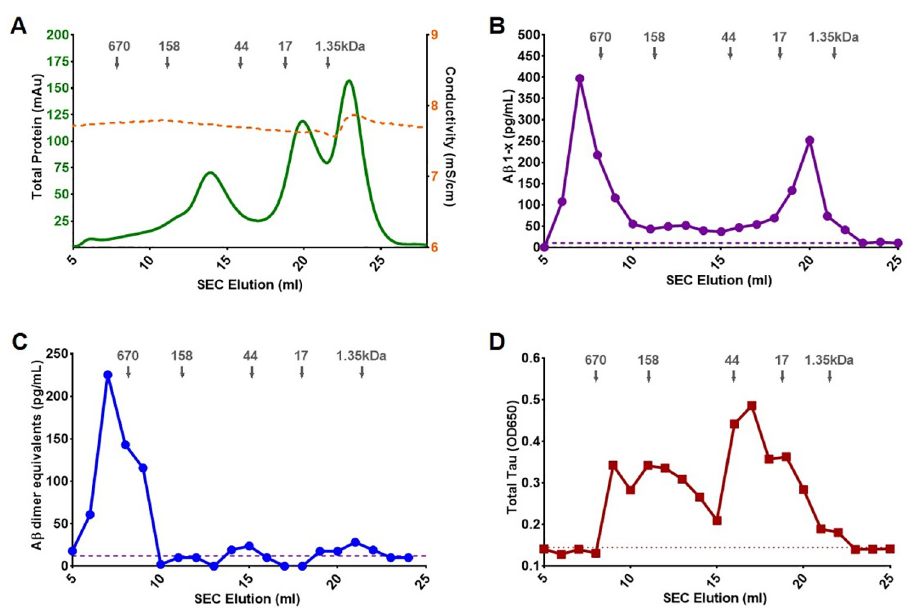
Fig 3. Representative SEC profile of total protein, conductivity, total A β level, oligomeric A β level, and total tau levels from a CDR3 patient. Total protein and conductivity were measured by UV detector (mAu) and conductivity detector (mS/cm); the levels of total A β , oligomeric A β , and tau in each fraction were measured by ELISA. (A) SEC elution profile of total protein and conductivity; (B) High molecular weight A β aggregates/oligomers (MW � 670 kDa) was detected in Fractions 6 to 9; low molecular weight A β (MW � 17 and � 1.35 kDa) was detected in Fractions 18 to 22; no other major peak was measured in other fractions, however, very low signals just above the lower detection limit (dashed line) were identified in intermediate fractions; (C) High molecular weight A β aggregates/oligomer (MW � 670 kDa) was detected in Fractions 6 to 9, no other major peak was measured in the other fractions; (D) Total tau was detected in Fractions 9 to 22; the largest level of total tau was detected in Fractions 16 to 17 with an estimated MW around 44 kDa.